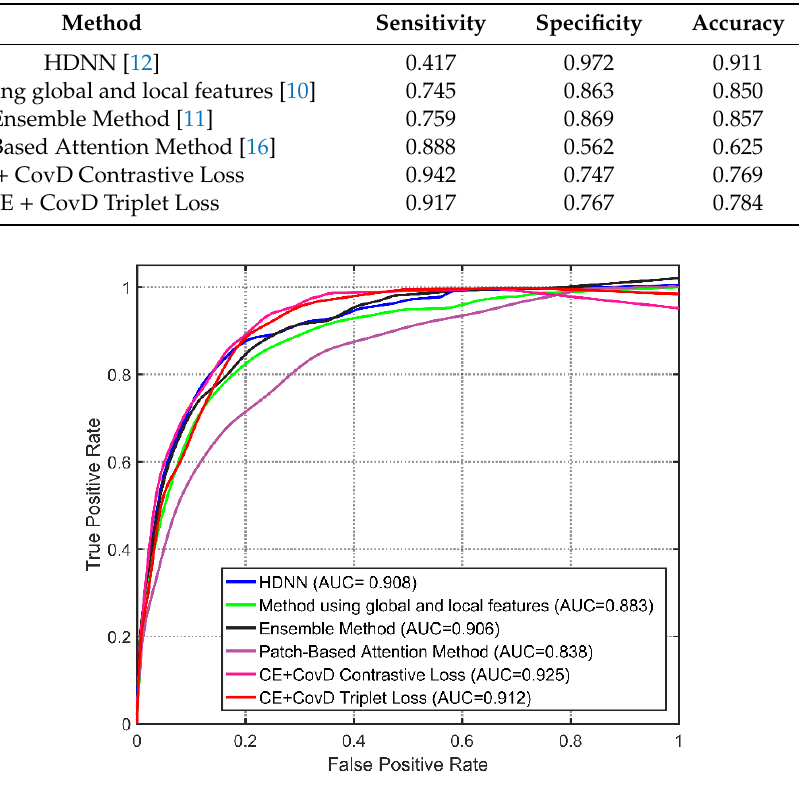
Figure 4. ROC curves and AUC of our method and the other methods.